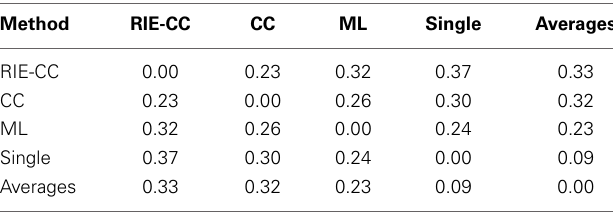
Table 5 | Discrepant classification rates among methods. Method